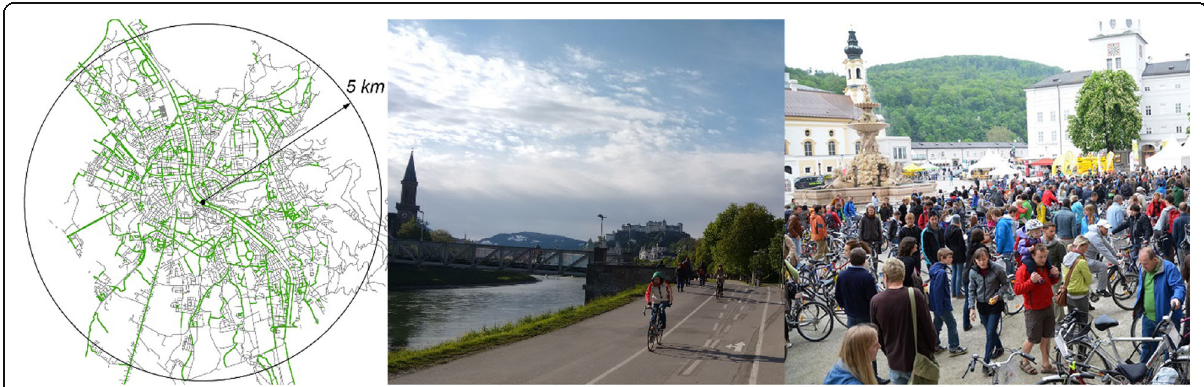
Fig. 3 Case study Salzburg (Austria): linear bicycle infrastructure in green (left), bicycle way along the Salzach river (center), bicycle spring festival